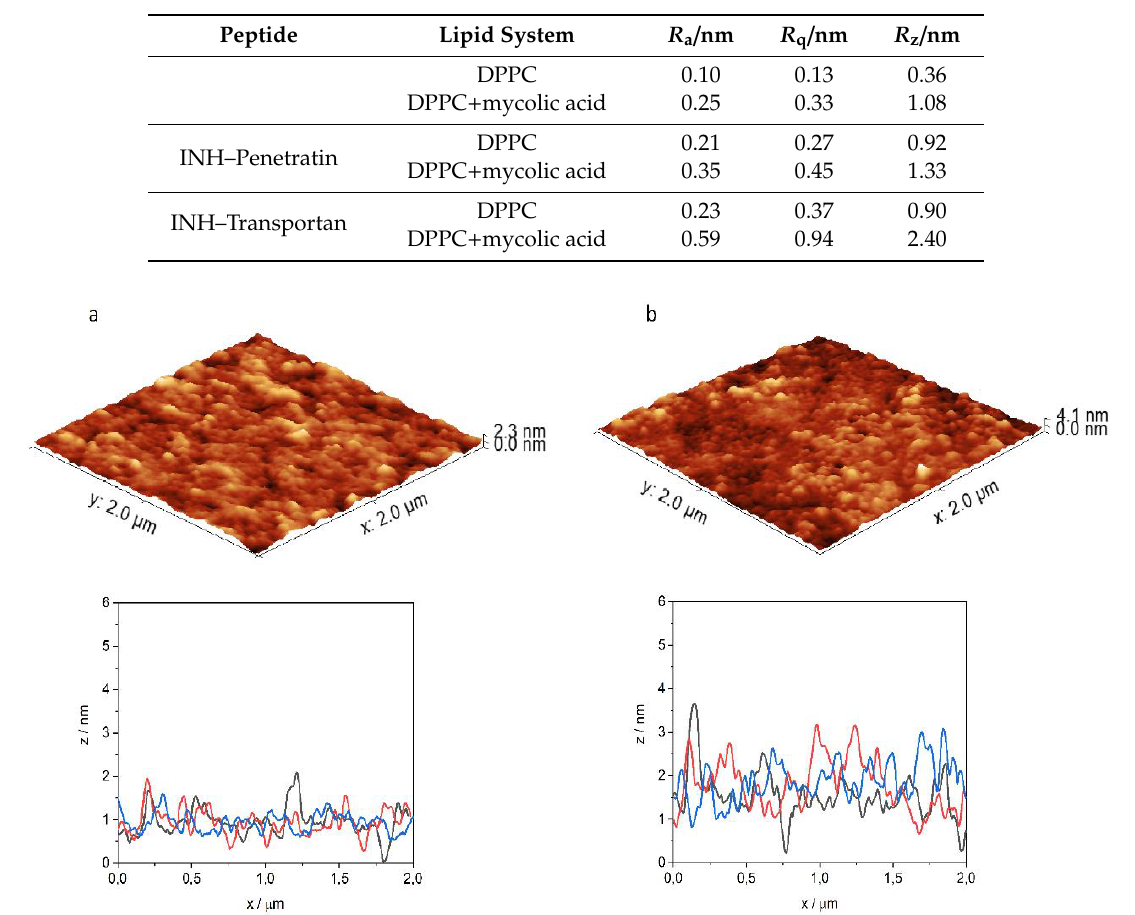
Table 2. Roughness values, R a , R q and R z characterizing the morphology of lipid layers and penetrated lipid layers determined by AFM imaging.